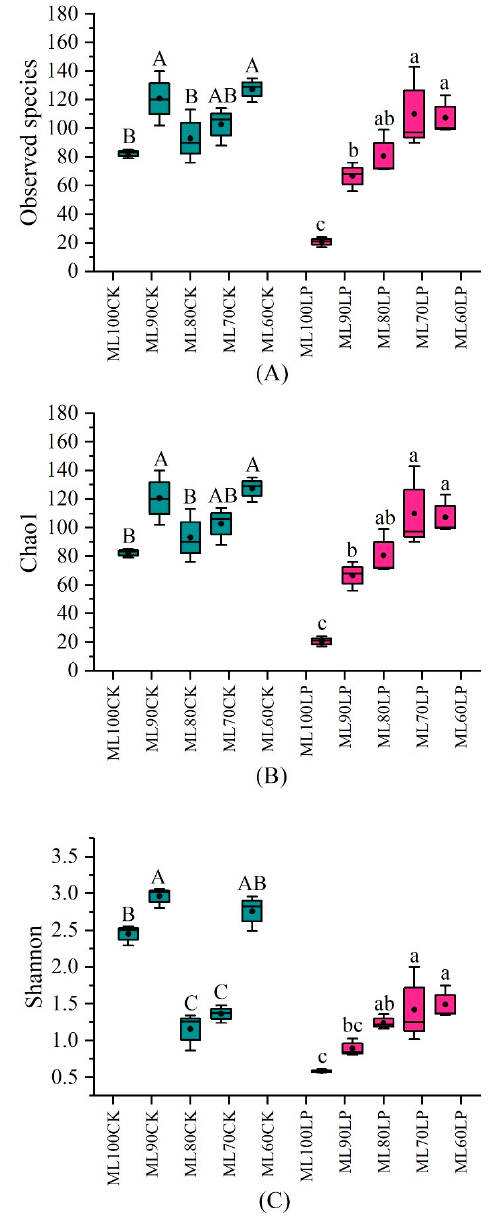
Figure 2. Boxplots of observed species ( A ), Chao1 ( B ) and Shannon ( C ) indices of bacterial communities in mixed silage. CK, silage without inoculation; LP, silage inoculated with L. plantarum A345. The numbers after “ML” indicate the proportion of mulberry leaves in the silage. Means with different capital letters represent significant difference among different mixed ratios in non-inoculated silage at p < 0.05. Means with different small letters represent significant difference among different mixed ratios in the inoculated silage at p < 0.05 ( n = 3, bars indicate standard error of means).